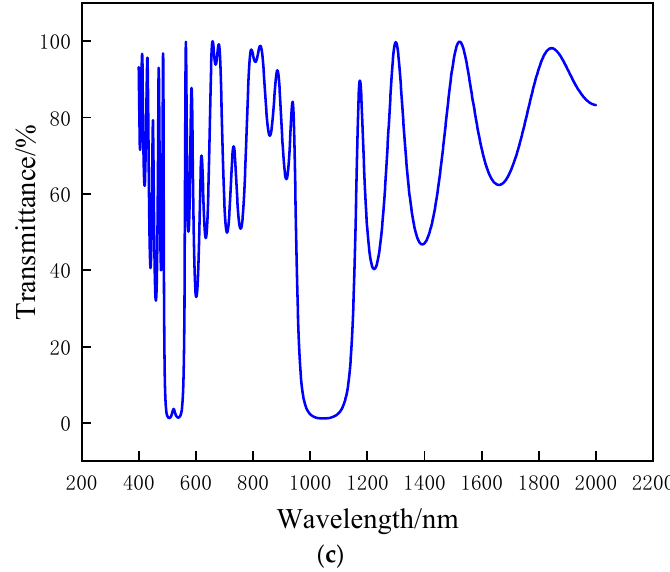
Figure 1. Theoretical transmittance spectra of highly reflective ( a ) TiO 2 /SiO 2 , ( b ) HfO 2 /SiO 2 , and ( c ) Ta 2 O 5 /SiO 2 films.